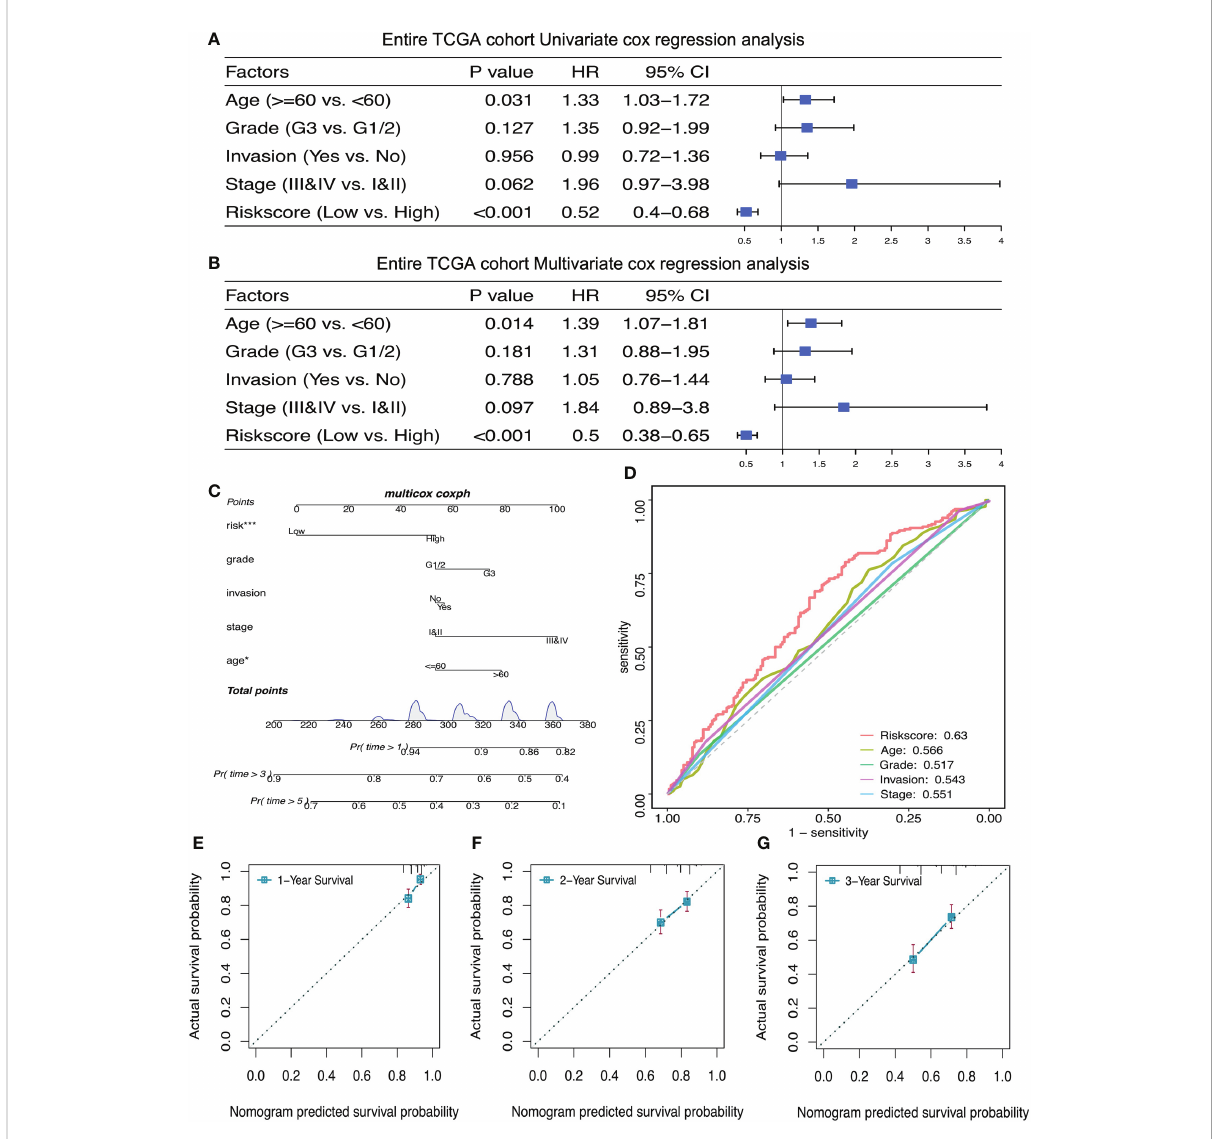
FIGURE 6 The prognostic risk signature was an independent prognostic factor of ovarian cancer. (A, B) Univariate and multivariate Cox regression analyses of independent risk factors for OS in patients with ovarian cancer. (C) Nomogram for independent risk factors for OS in patients with ovarian cancer. D: AUC to verify the independent risk factors. (E – G) Calibration curves of nomogram for the prognostic scoring model at 1, 2, and 3 years. *P < 0.05, ***P <